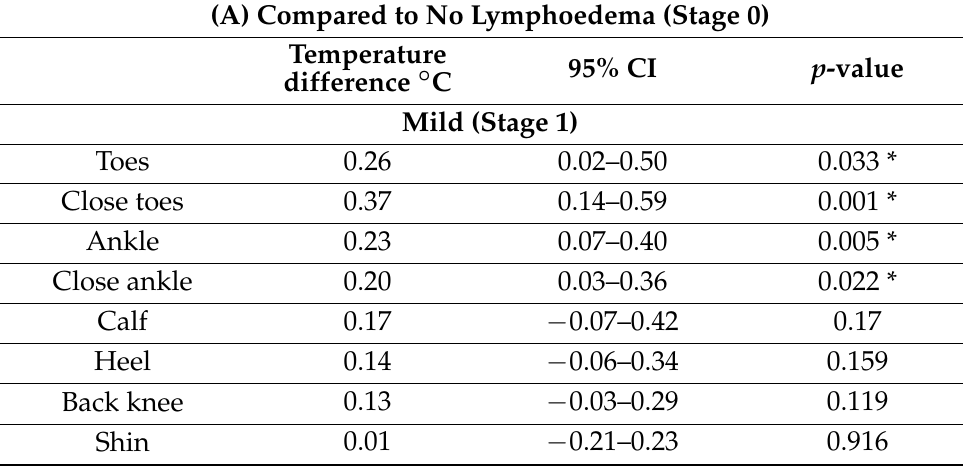
Figure 3. Comparison of temperature differences at regions of interest (ROIs) by lymphoedema stage. First section: No lymphoedema (Stage 0) compared to mild, moderate, severe (Stages 1–3); second section: mild (Stage 1) compared to moderate and severe lymphoedema (Stages 2 and 3), and third section: moderate (Stage 2) compared to severe lymphoedema (Stage 3). The red dashed line indicates a coefficient value of zero. Therefore, a coefficient which confidence interval (CI) crosses the dash/zero line is not significant at 95% level. Table 1. Difference in temperature between lymphoedema